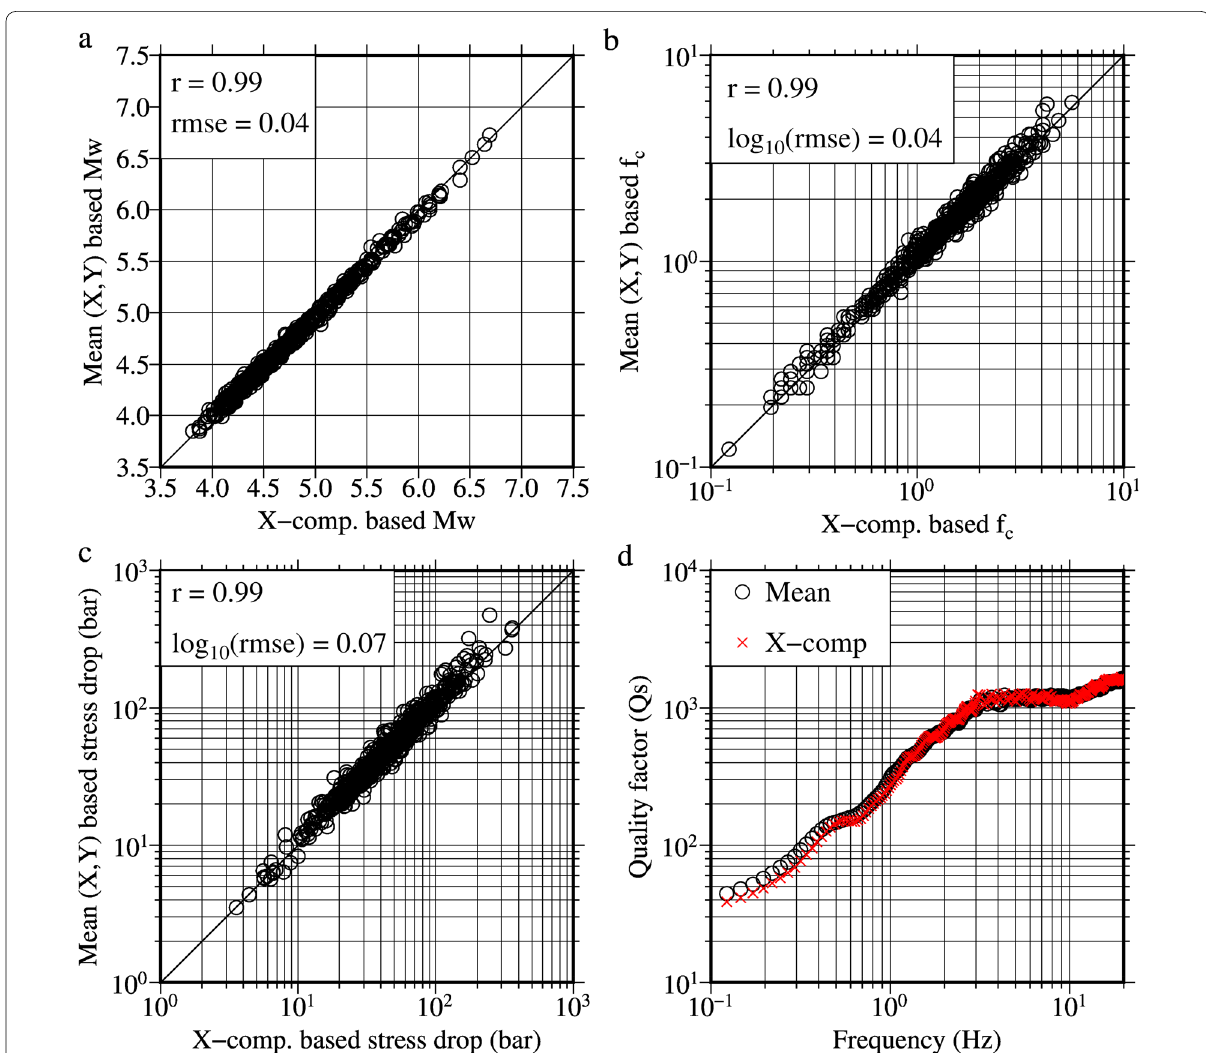
Fig. 10 a Comparison of the estimated magnitudes (Mw) between the inversions of the X-component spectra and the mean spectra of X and Y components. b , c Similar to the plot a , but for the corner frequencies (Hz) and stress drops, respectively. d Comparison of the quality factors between the two inversions plotted against the